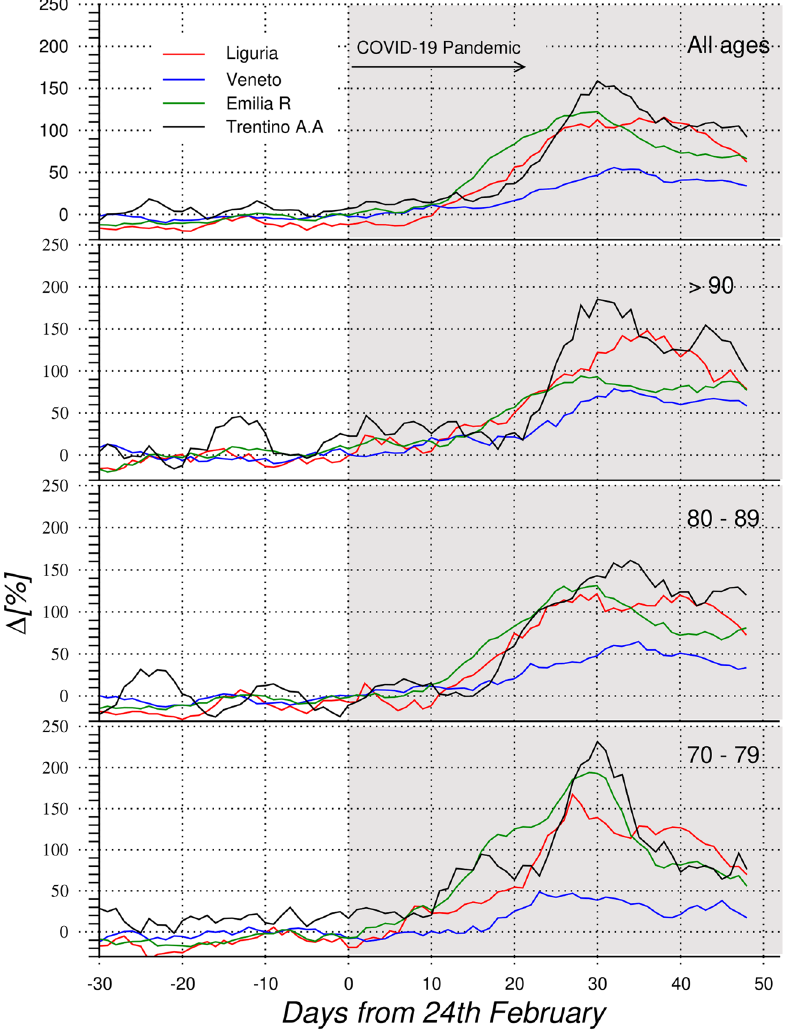
Figure 2. Percentage increase (cid:31) [ % ] of daily mortality in Liguria (red line), Veneto (blue line), Emilia R. (green line) and Trentino A.A. (black line), for age classes. Starting from bottom: 70–79 years; 80–89 years; older than 90 years; all resident people. Seven days running average is